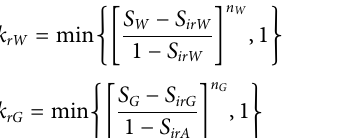
Frontiers in Energy Research |